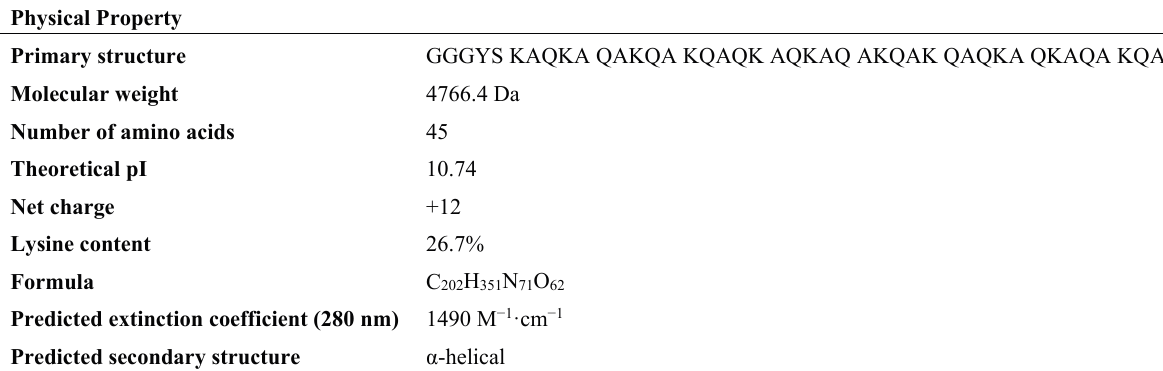
Table 1. Physicochemical parameters of peptide